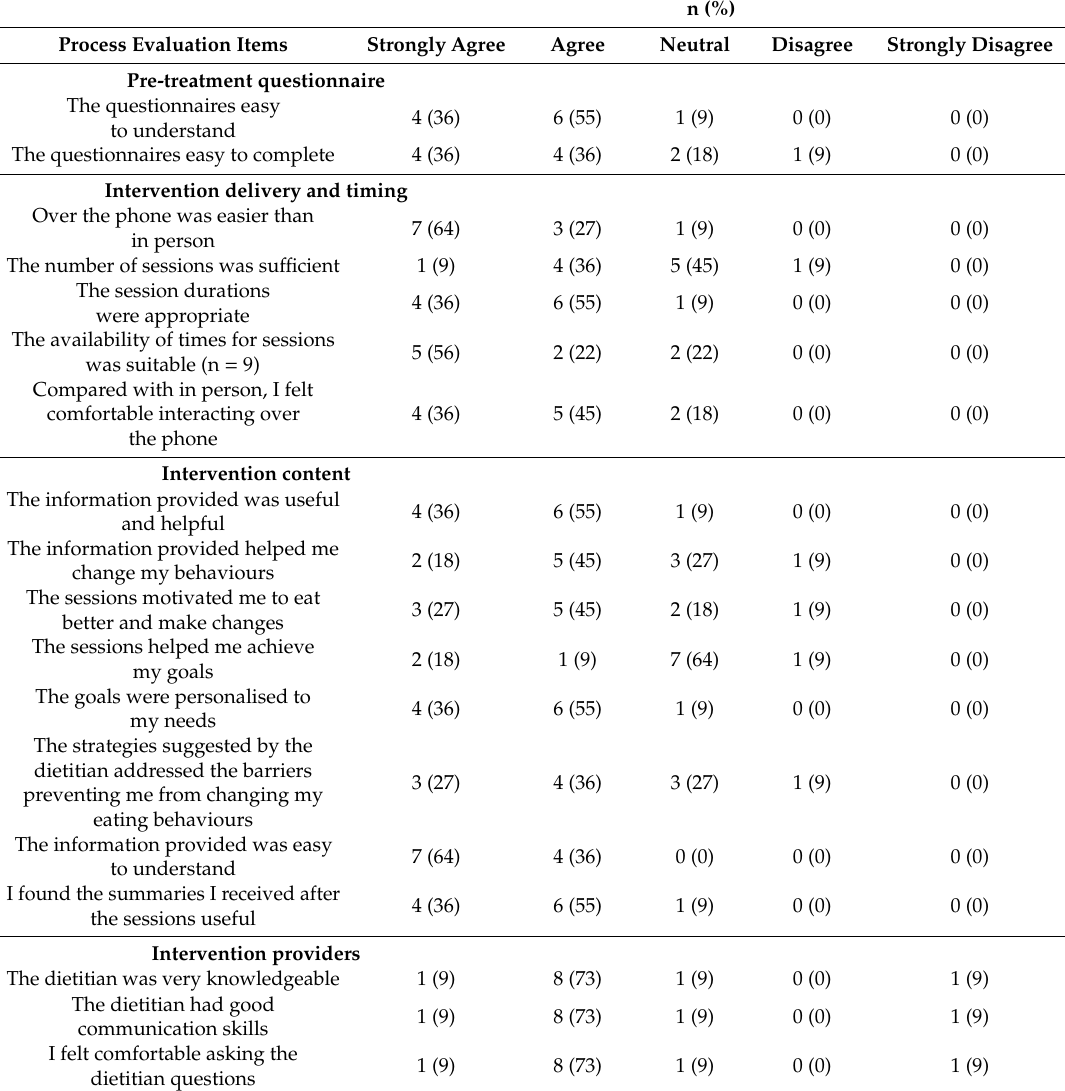
Table 2. Process evaluation questionnaire responses from participants in the FoodFix intervention randomised controlled trial (n =